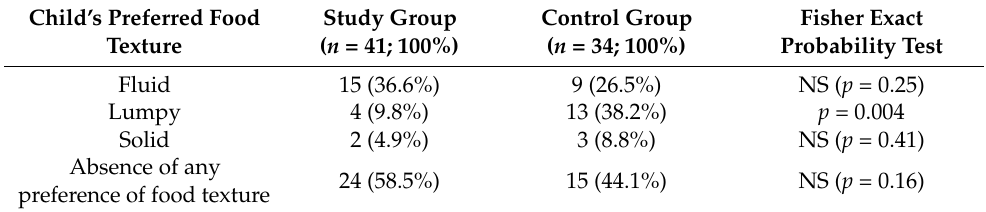
Table 8. Child’s preferred food texture at the age of 6 months or later in the study group and the control group (question I/18).